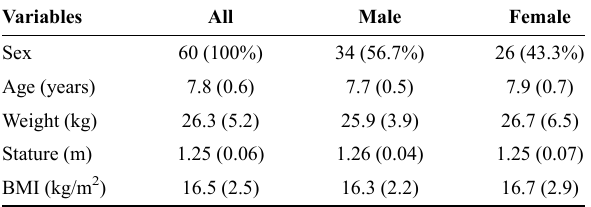
Table 1 - Descriptive statistics of the participants. Variables